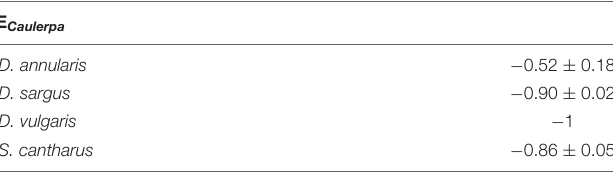
TABLE 2 | Mean ± S.E. values for Ivlev’s electivity Index (E), as a measure of the electivity of the four sparid fish species studied towards the invasive